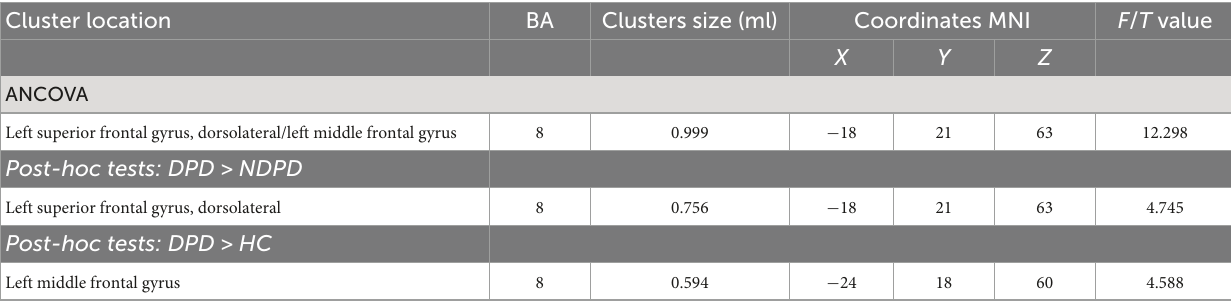
TABLE 2 The differences of ReHo among three groups.